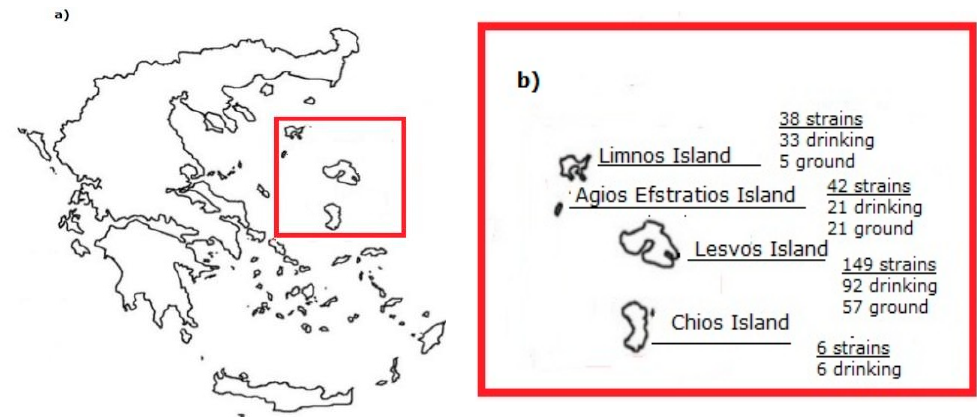
Figure 1. Sampling areas: ( a ) map of Greece; ( b ) the four Greek islands and number of isolated E. coli strains from